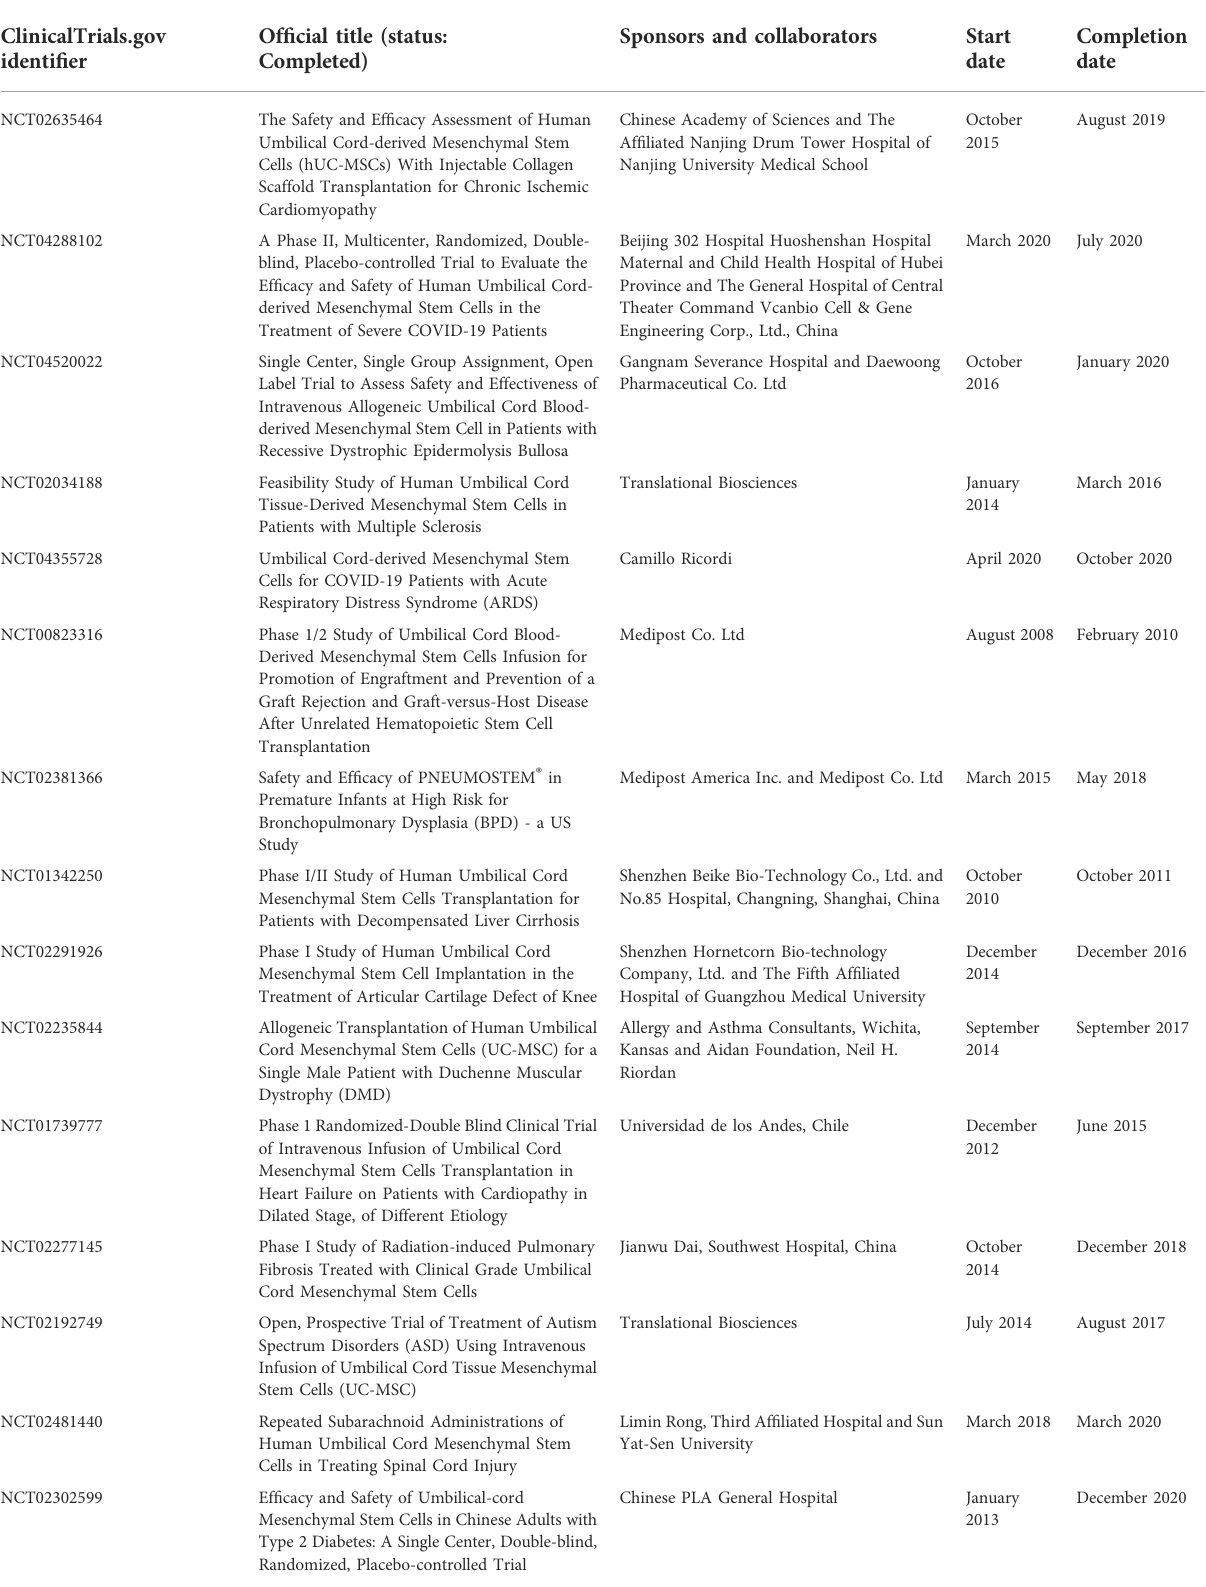
TABLE 3 Clinical Trials on UC-MSCs recruiting patients from